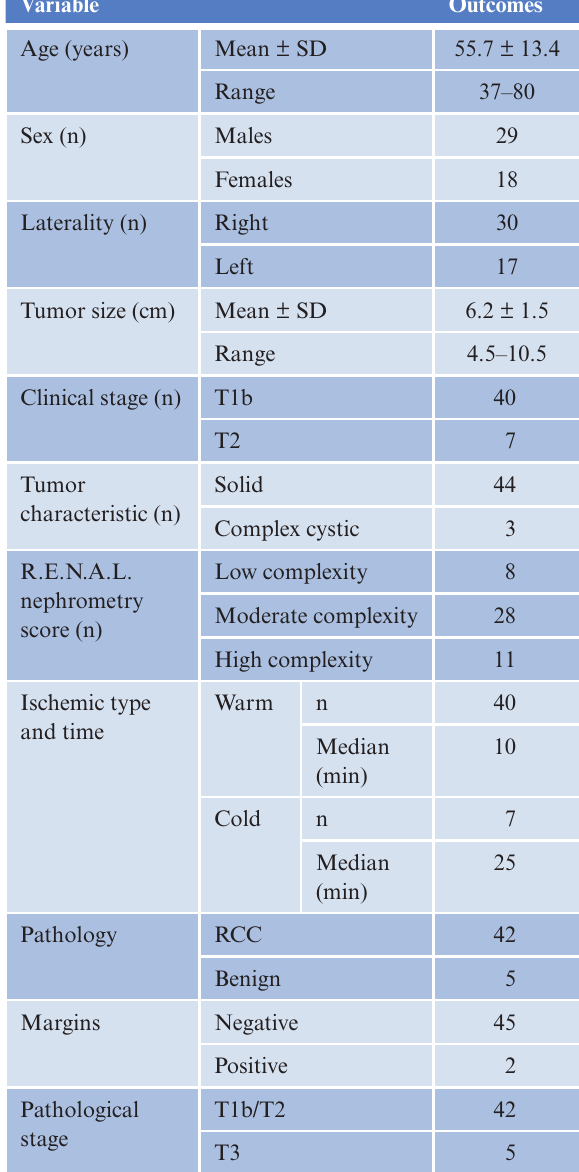
Table 1: Clinical and pathological